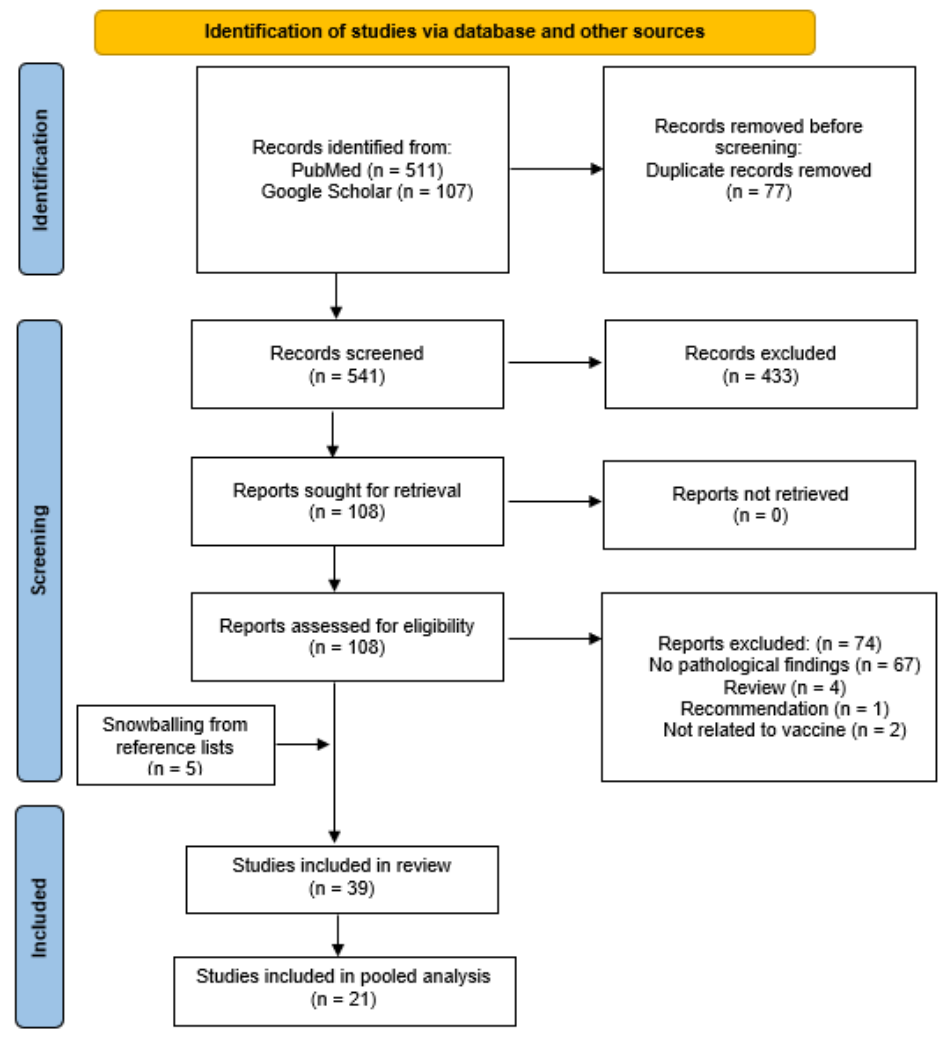
Figure 1. PRISMA